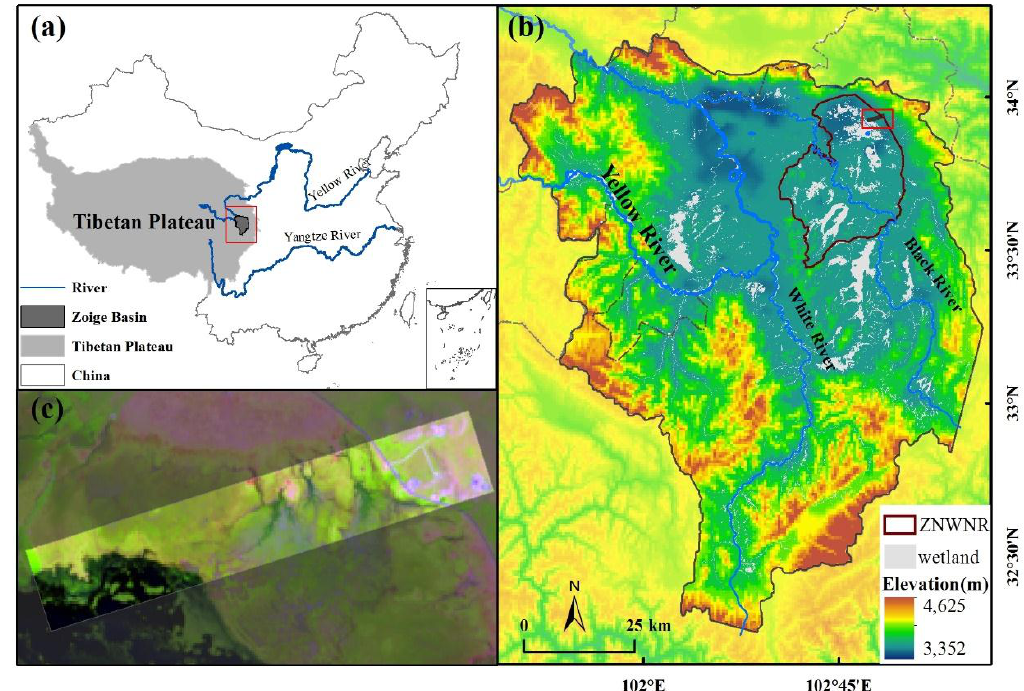
Figure 1. Location of the Zoige Plateau ( a ); the Zoige Wetland National Nature Reserve (ZNWNR) ( b ); and the typical wetland degradation transect studied in this work ( c ).